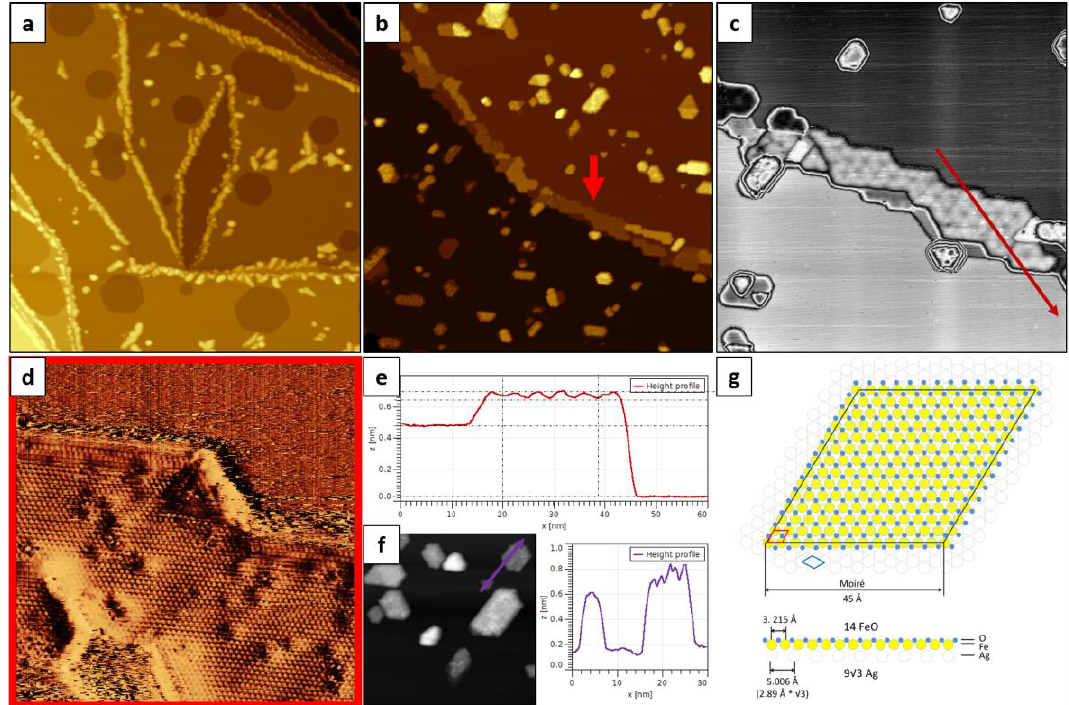
Figure 1. Large-scale topographic scanning tunneling microscopy (STM) images (300 × 300 nm 2 ) of 0.5 ML Fe deposited onto Ag(111) substrate kept at room temperature ( a ) and subsequently oxidized in 1 × 10 −6 mbar O 2 at 700 K ( b ). ( c ) and ( d ) are zoom-in images of (b) (100 × 100 nm 2 and 20 × 20 nm 2 , respectively) showing the Moiré superstructure (c) and the atomic structure (d) of the reconstructed island (marked with red arrow in (b)). ( e ) presents the height profile marked in (c). ( f ) shows an STM image (75 × 75 nm 2 ) of islands with ill-defined structure, as well as an exemplary height profile of such islands (marked on the neighboring STM image). ( g ) presents the proposed model for the observed Moiré superstructure, where the blue rhombus marks the Ag(111) surface cell, the red one the FeO(111) cell and black the Moiré cell (see text for details). Tunneling parameters: +0.7 V (all images), 0.4 nA (a,d,f) and 1.0 nA (b,c).